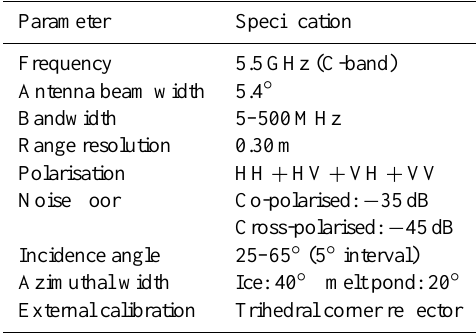
Table 1. Scatterometer radar parameters.